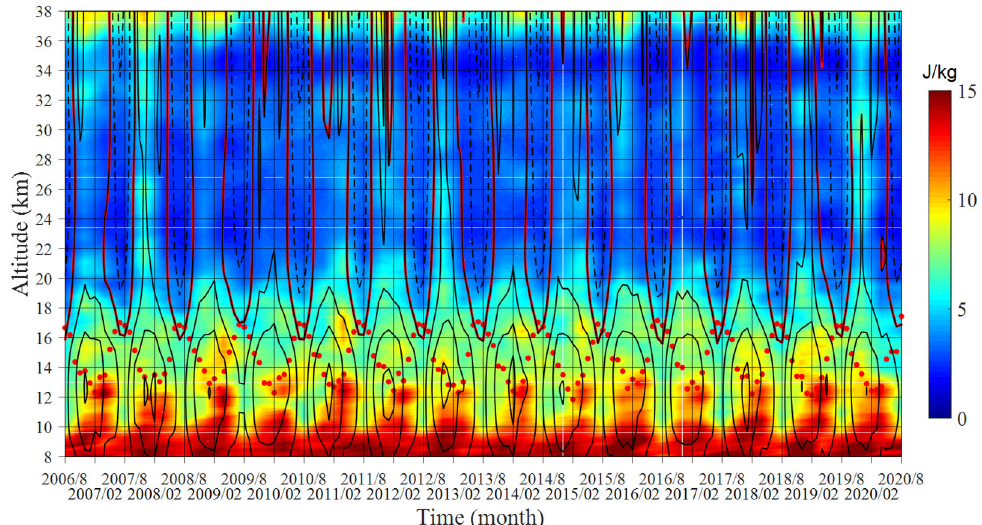
Figure 6. The vertical distribution of the monthly mean GW Ep over TP (25~41°N, 68~105°E) at 8~38 km from August 2006 to September 2020. The red solid dot represents the Lapse Rate Tropopause, the black solid line represents the westerly wind, the black dotted line represents the east wind, the red solid line represents the zero ‐ speed wind, and the zonal wind data are provided by the ERA5.